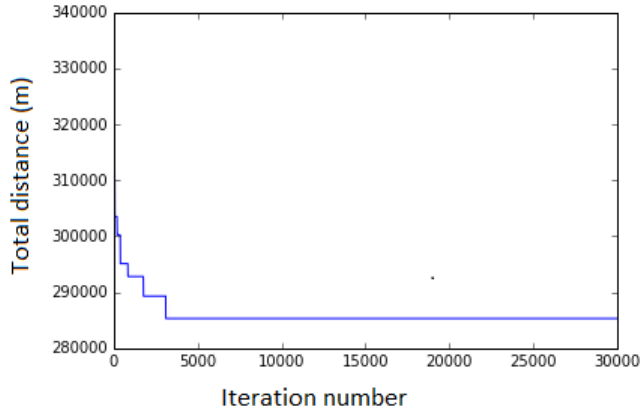
Figure 2. Search evolution. Vehicle routes are shown in Figures 3–5.